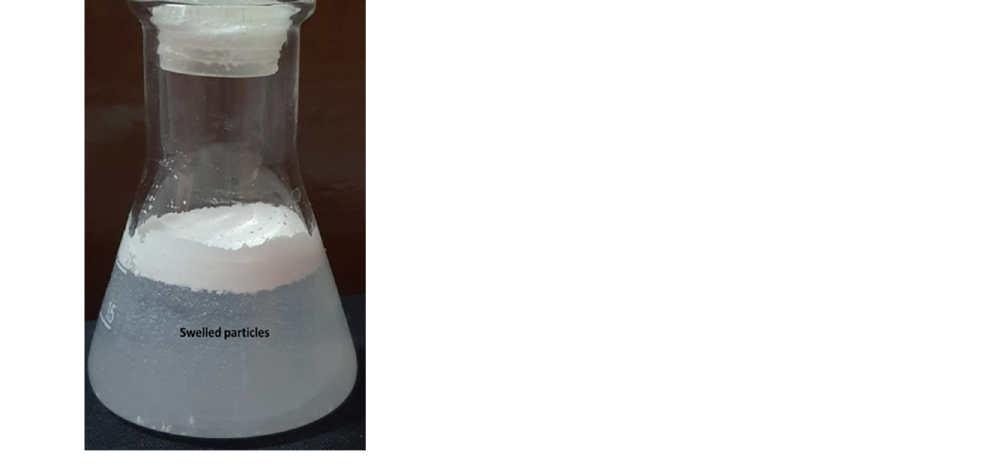
Figure 9. Dispersion of the CHPE polyester immediately after adding 0.5 g to 25 mL of